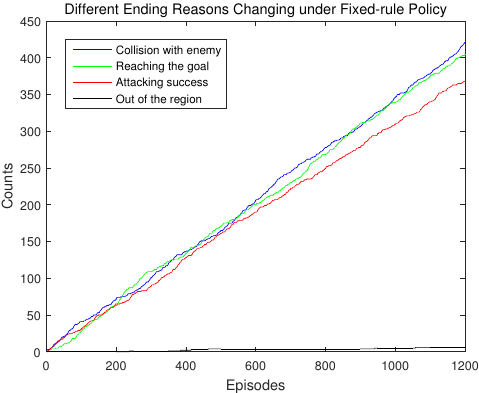
Figure 13. The numbers of different ending reasons when using the fixed-rule